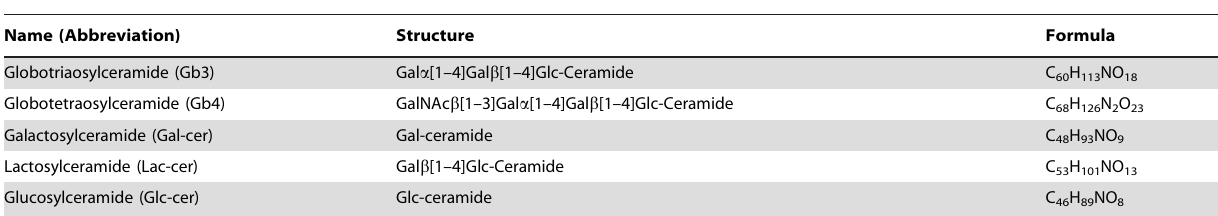
Table 1. Glycolipids used in this